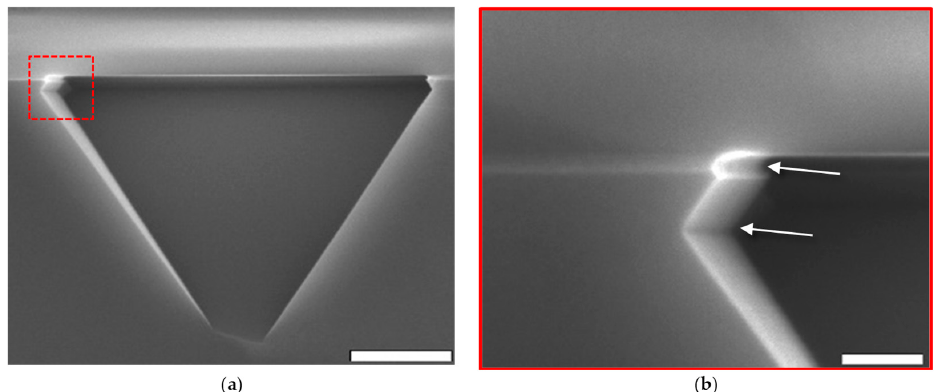
Figure 20. Cross-sectional SEM images showing corner lithography performed with ( a , b ) EF 1.9 inside a G3. ( b ) Enlarged zoom-in of the area indicated by the red dashed line. The white arrows indicates the extra corners formed in Si. Scalebars: ( a ) 500 nm and ( b ) 100 nm.